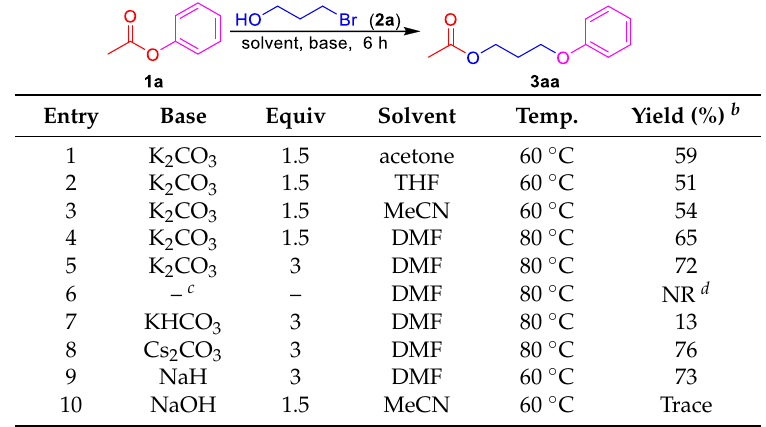
Table 1. Condition optimization for aryloxyalkyl esterification. a